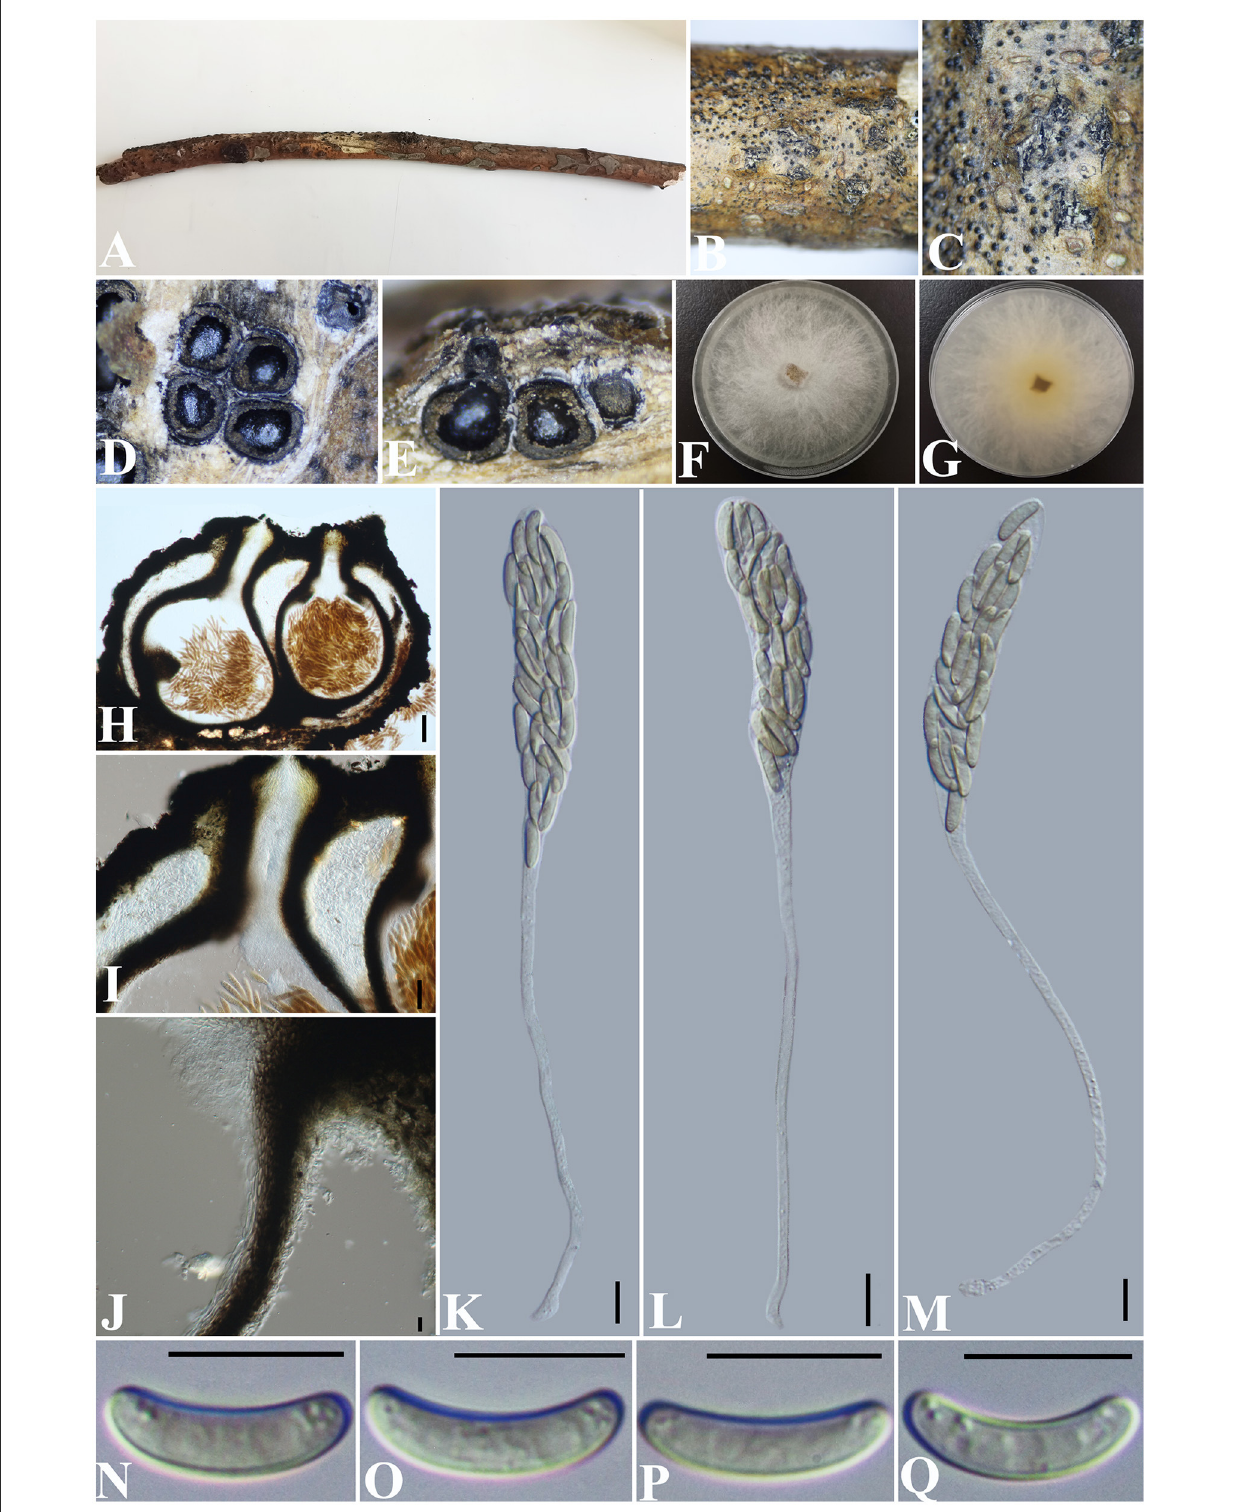
FIGURE2 Allocryptovalsa rabenhorstii (GMB0416). (A) Material. (B, C) Close-up of stromata. (D) Transverse section through stromata. (E) Vertical section through stromata. (F, G) Culture on PDA. (H) Section through the ascostroma. (I) Ostiolar canal. (J) Peridium. (K–M) Asci. (N–Q) Ascospores. Scale bars: (H) = 100 µ m; (I) = 50 µ m; (J–Q) = 10 µ